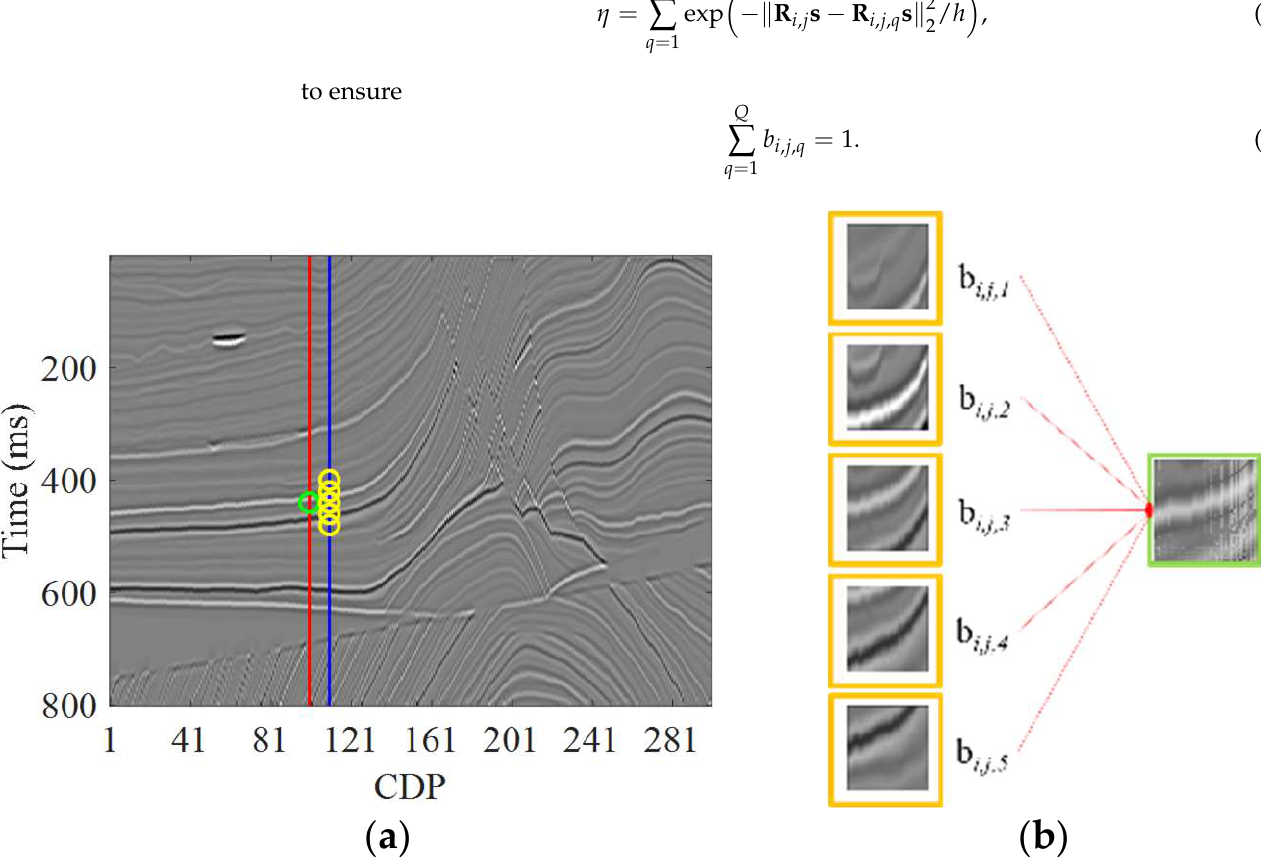
Figure 1. The schematic diagram for obtaining NLM interpolation coefficients based on the observed poststack seismic record. ( a ) The elastic parameters for interpolation (green circle) and the known points (yellow circle) at well location (blue line), and ( b ) seismic patches centered at borehole points (yellow rectangle) and interpolated point (green rectangle) are used to calculate the interpolation weight coefficients b i,j,q . Seismic patches are extracted with a sliding window shown in Figure 2a. The red and yellow rectangles indicate the sliding window. The seismic profile is decomposed with the sliding window along vertical and horizontal directions. Each patch represents the local feature of the central sampling point. Therefore, we only show parts of seismic patches in Figure